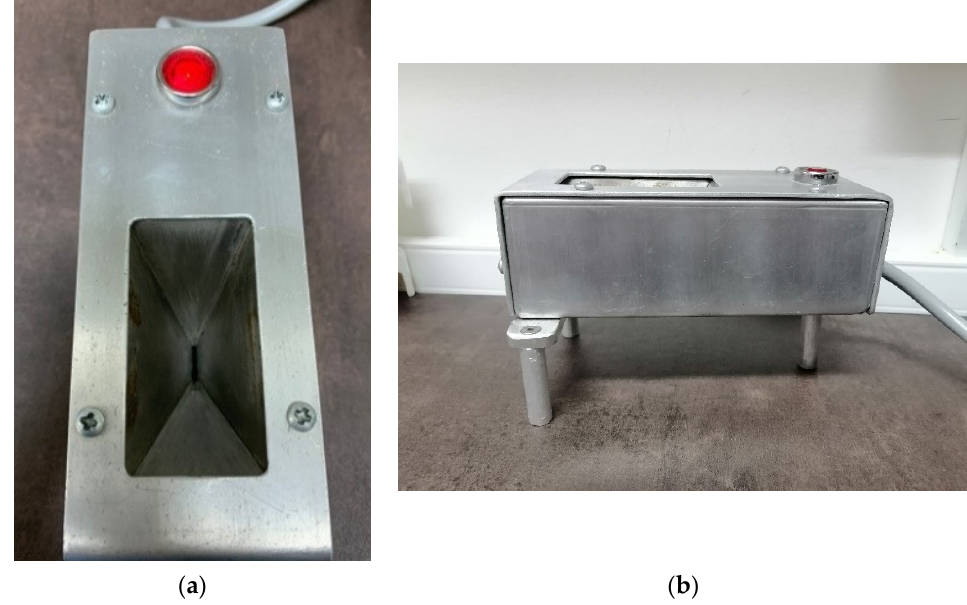
Figure A4. Thermo-regulated stainless conical hotplate used to thaw cryopreserved semen; ( a ) top view, ( b ) lateral view.